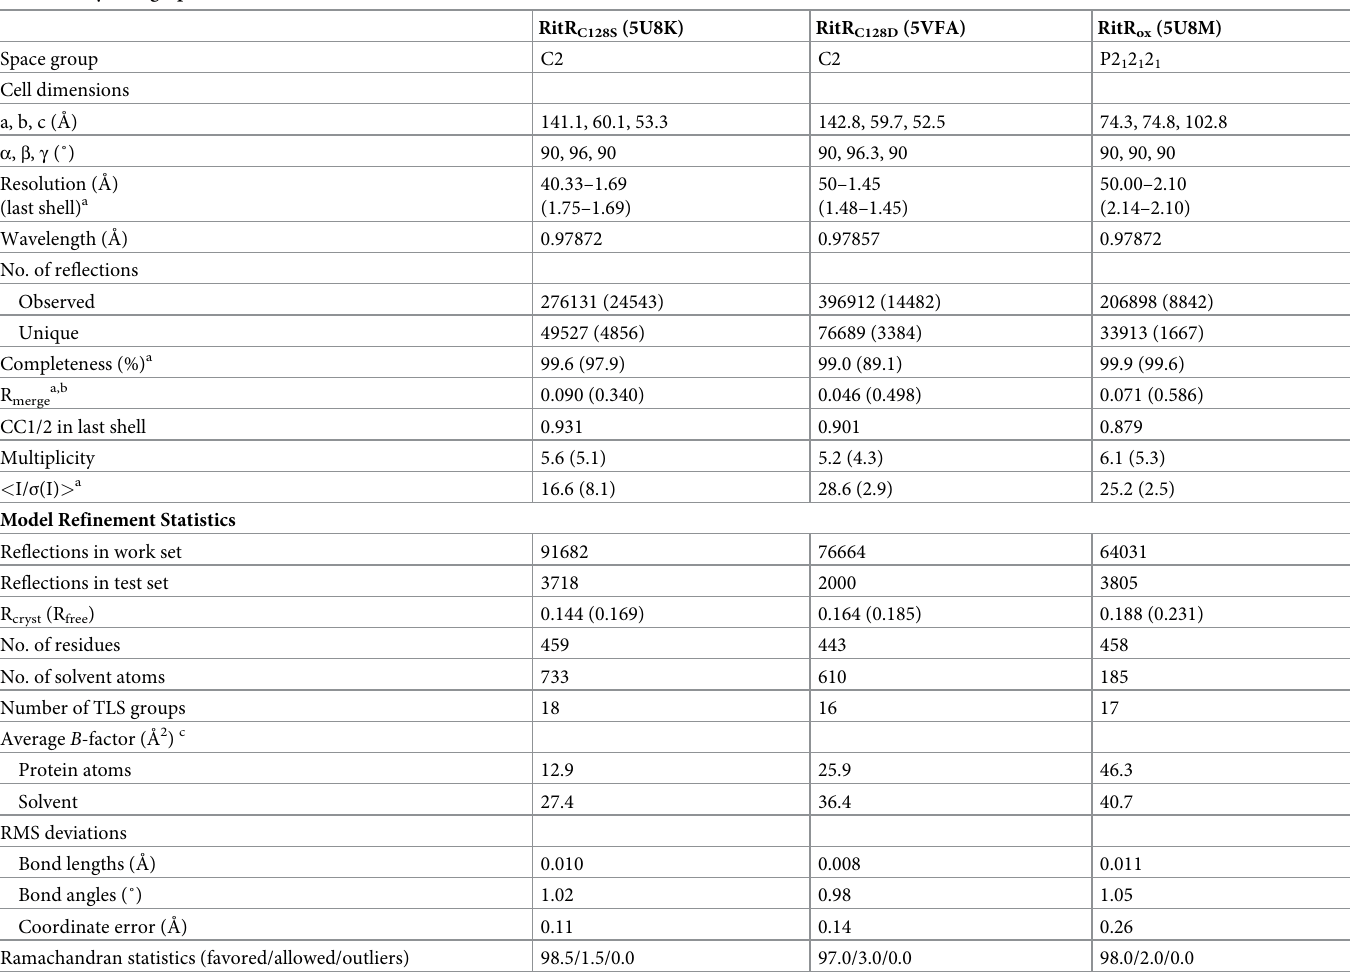
Table 1. Crystallographic data collection and refinement